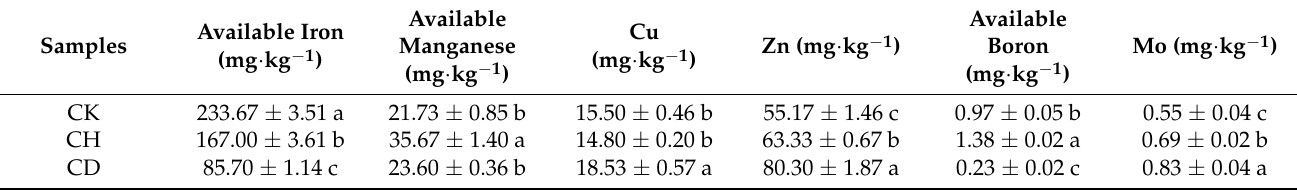
Table 2. Mineralogy and chemical compositions of three initial soil samples.